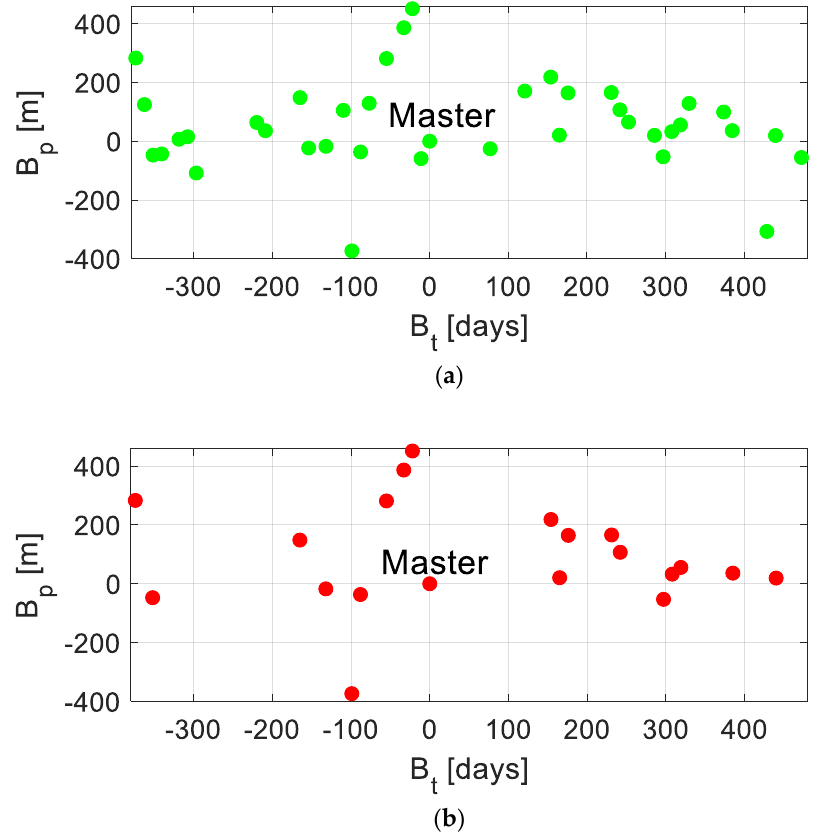
Figure 2. Distribution of the perpendicular baselines vs. the temporal baselines, in ( a ) the 39 baselines of the single polarization case, in ( b ) the 20 baselines of the dual polarization case.